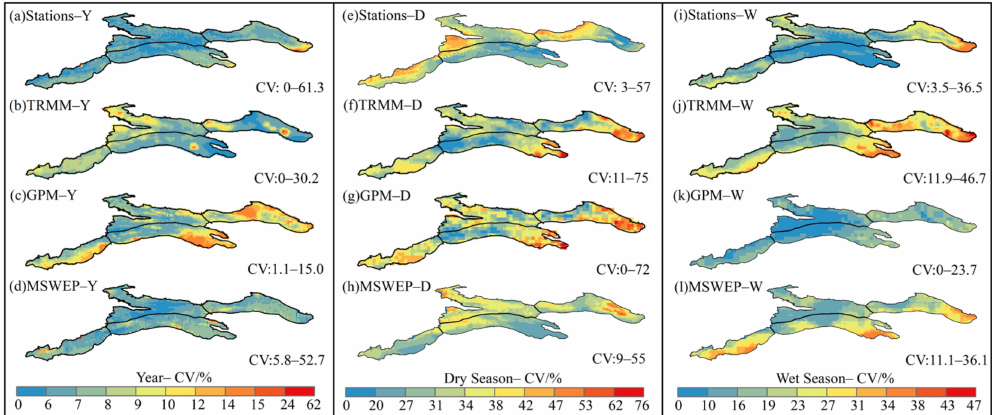
Figure 9. Spatial distribution of CV in station interpolation ( a , e , i ), TRMM ( b , f , j ), GPM ( c , g , k ) and MSWEP ( d , h , l ). Annual scale ( a – d ); Dry season ( e – h ); Wet season ( i – l